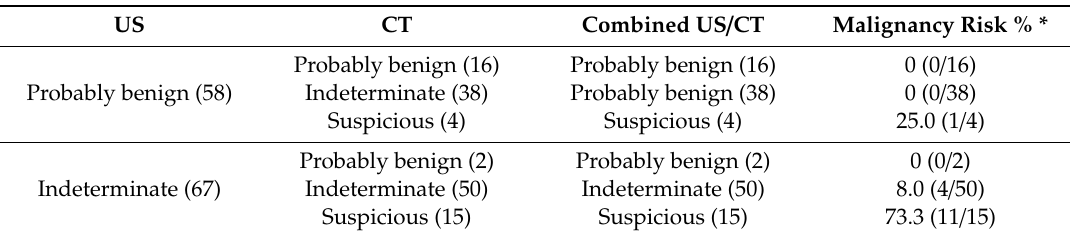
Figure 1. Changes in the LN classification with the addition of CT. CT—computed tomography, LN—lymph node, US—ultrasonography. Table 3. Malignancy risks of the combined US / CT categories according to the US and CT categories. Unless otherwise indicated, data in parentheses are the number of